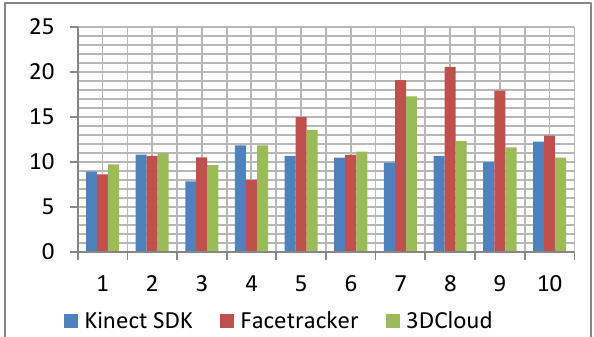
Figure 24. Mean RMSE (in degrees) for the pitch for each